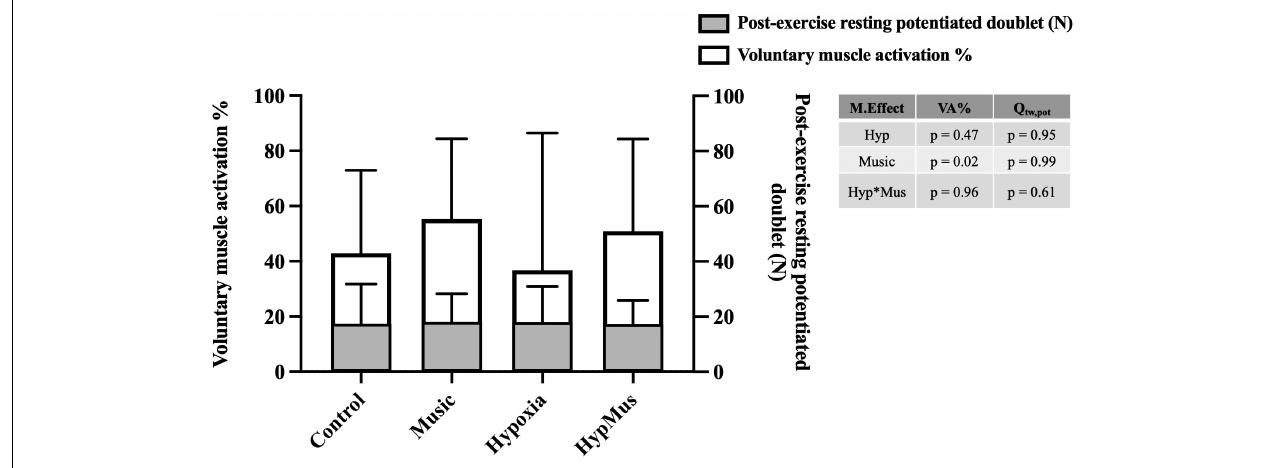
FIGURE 4 | Voluntary muscle activation % represented in the white bars, and post-exercise resting potentiated doublet force (N) represented in the gray bars. Main effects are outlined in the table to the right of the graph, M.Effect, main effect; VA%, voluntary muscle activation %; Qtw, pot , post-exercise resting potentiated doublet force; Hyp, hypoxia; Hyp*Mus, hypoxia × music